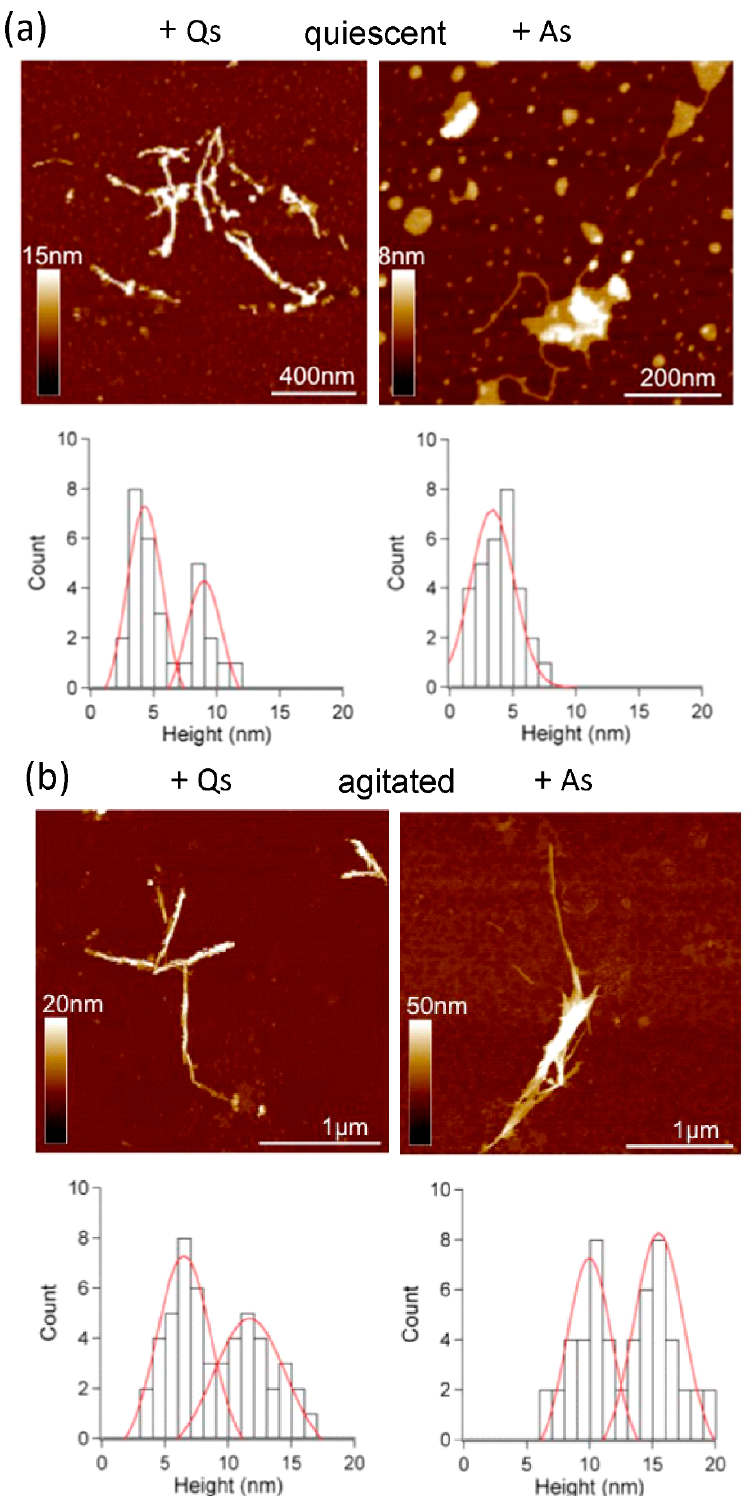
Figure 7. Atomic Force Microscopy Analysis. Fibrils formed under ( a ) quiescent and ( b ) agitated conditions with the addition of 5% v / v seeds preformed with quiescent (Qs) or agitated (As) incubation. Height distribution analysis for quiescent incubation shows height populations of 4.2 ± 1.2 nm and 9.1 ± 1.2 nm ( n = 40) with addition of A seeds ( a , left), and 3.5 ± 1.3 nm ( n = 40) with addition of Q seeds ( a , right). Height distribution analysis for agitated incubation shows height populations of 6.4 ± 1.5 nm ( n = 40) with addition of Q seeds ( b , left), and 9.9 ± 2.5 nm ( n = 40) with addition of A seeds ( b , right).